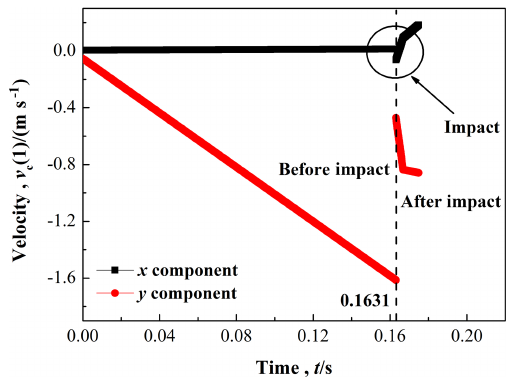
Figure 8. Motion analysis of the composite bar analyzed with digi- tal image processing method. Note that red boundaries and diamond symbols represent the profile and the central point of each marker, respectively.